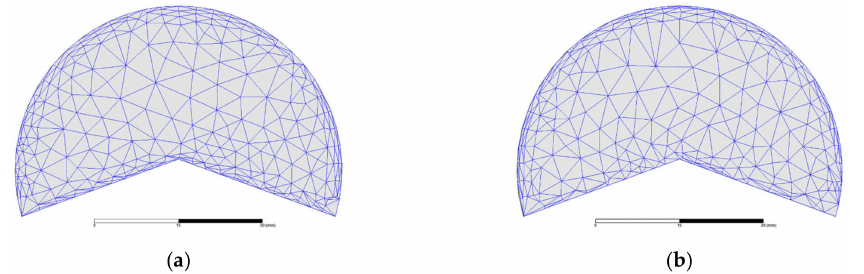
Figure 3. Model grids for electromagnetic analysis with ( a ) 10 ◦ cross angle and ( b ) 15 ◦ cross angle